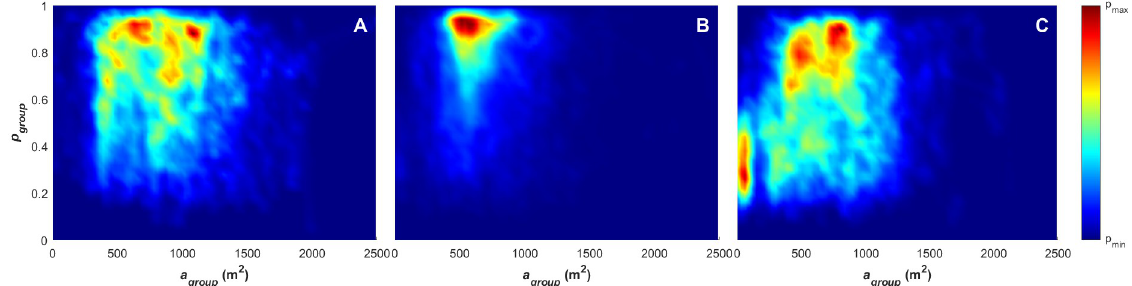
Fig 9. Density plots for paired group area ( A group ) and polarisation ( p group ) values across the attacking (A), defending (B) and out-of- play (C) game phases.